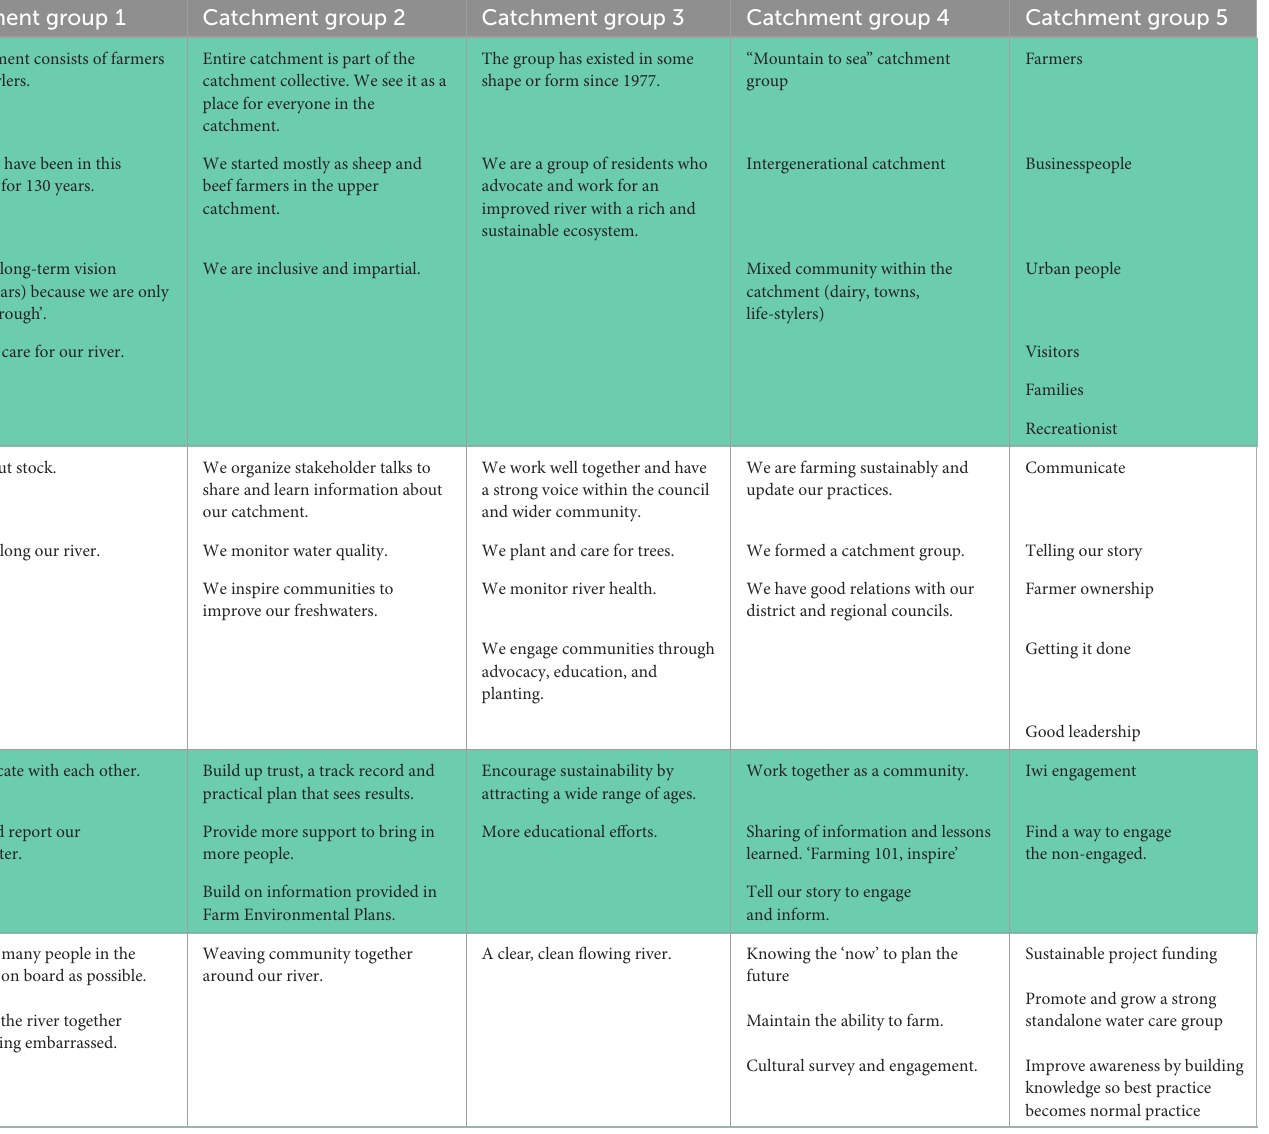
TABLE 2 A summary of the strengths, weaknesses, opportunities, threats, and long-term visions for five catchment groups as captured in their Catchment Journeys, as expressed by focus group